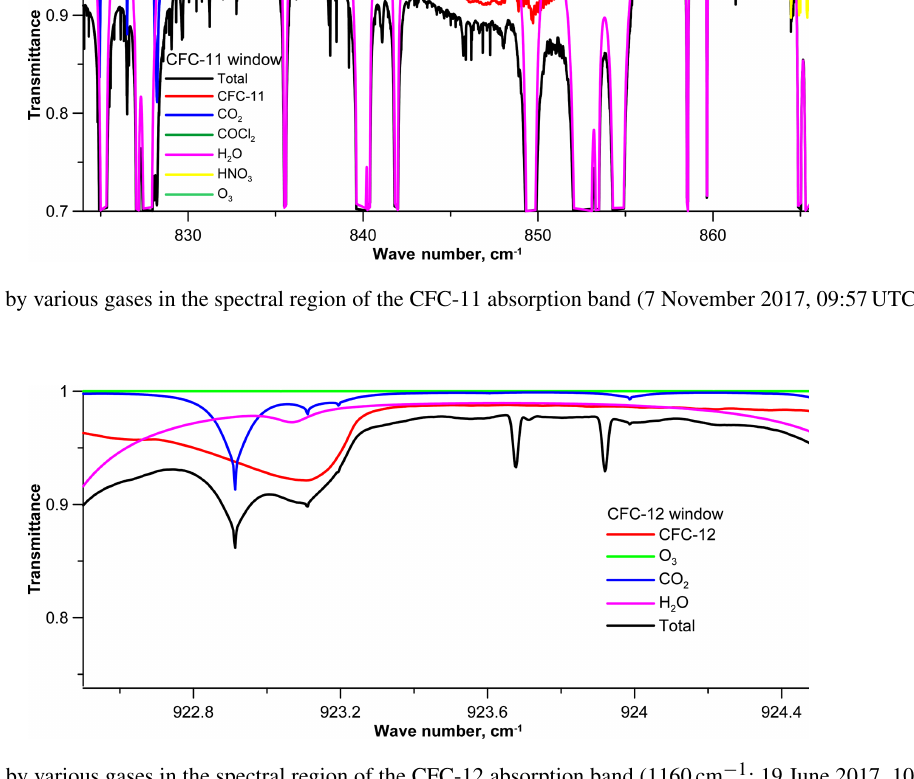
Figure A2. Absorption by various gases in the spectral region of the CFC-12 absorption band (1160cm − 1 ; 19 June 2017, 10:25UTC; SZA is 37 ◦ ).